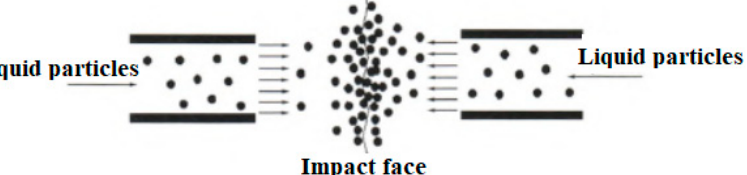
Figure 4. The principle diagram of high ‐ speed impact breaking for particles. Reproduced from [43], with permission from Chinese Journal of Energetic Materials (Han Neng Cai Liao),